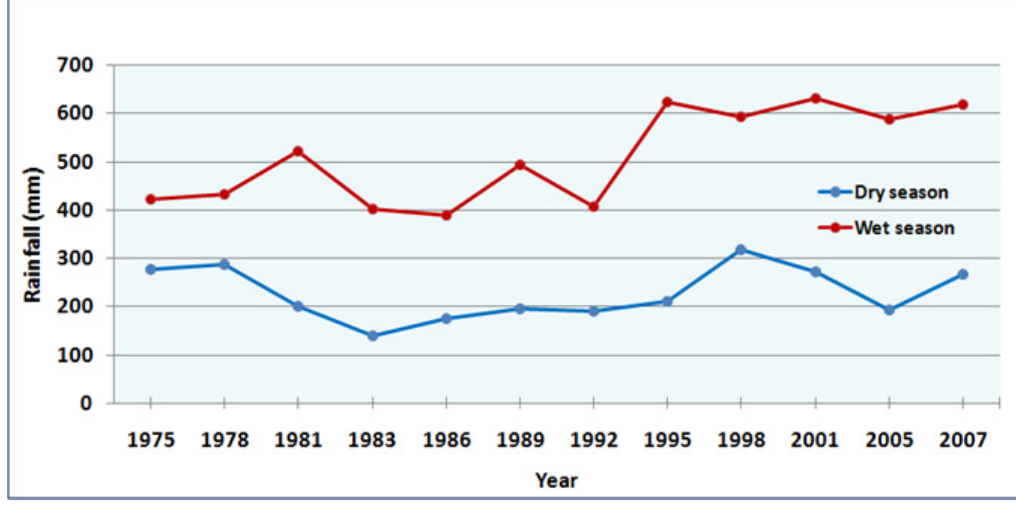
Figure 11. Wet and dry rainfall variation in Masai Mara between 1975 and 2007. Source: Kenya Meteorological